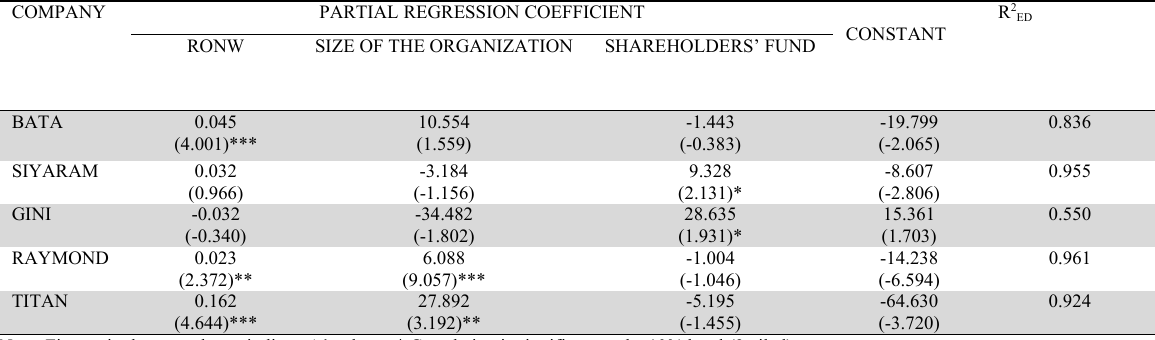
Table 4 Analysis of Multiple Regression of CCC on RONW, Size of Org. and shareholders’ Fund of the Selected Companies of Retail